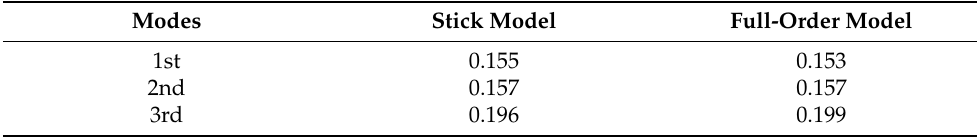
Table 3. Natural frequencies of the SEU from stick model and full-order model (unit: